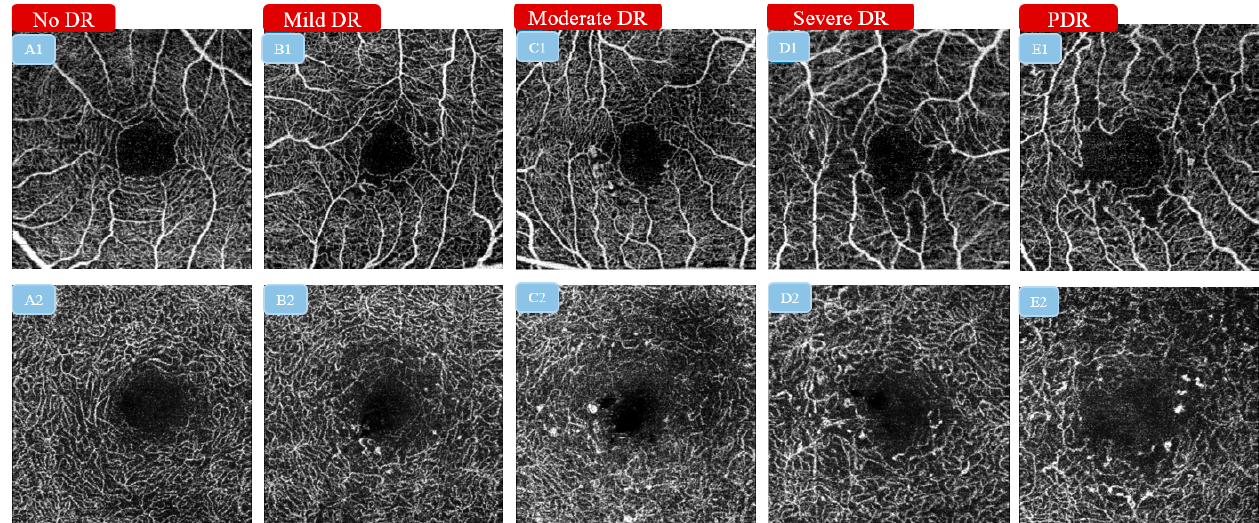
Figure 1. Examples of a series of 3 × 3 mm 2 superficial capillary plexus (SCP) and deep capillary plexus (DCP) optical coherence tomography angiography (OCT-A) images illustrating different severities of diabetic retinopathy. ( A1 – E1 ): SCP OCT-A images illustrating the alteration of the FAZ area and the surrounding vasculature from no DR to PDR. ( A2 – E2 ): DCP OCT-A images illustrating the alteration of the FAZ area and the surrounding vasculature from no DR to PDR. OCT-A: optical coherence tomography angiography; SCP: superficial capillary plexus; DCP: deep capillary plexus; FAZ: foveal avascular zone; DR: diabetic retinopathy; PDR: proliferate diabetic retinopathy.